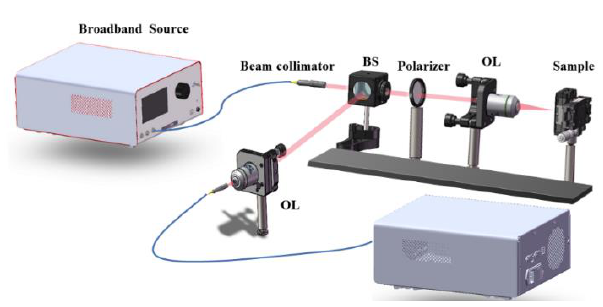
Figure 2. Schematic diagram of the experimental test setup.